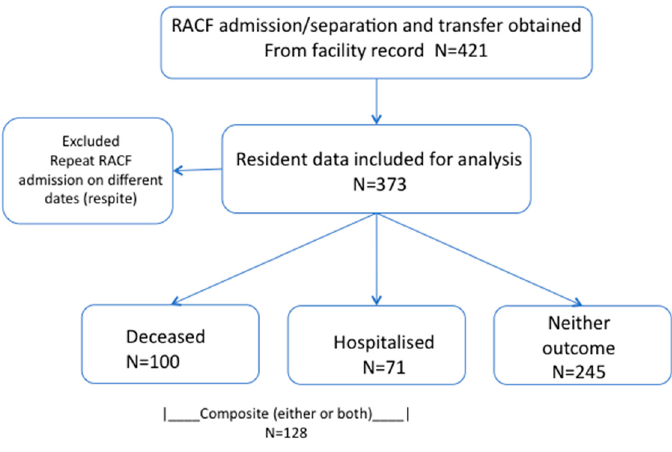
Figure 1. Resident eligibility, exclusion and relevant outcomes.